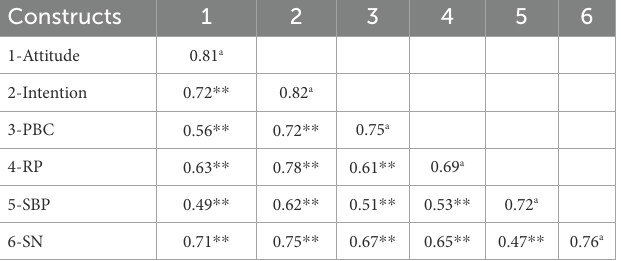
TABLE 4 Examining the discriminant validity of the research constructs. Constructs